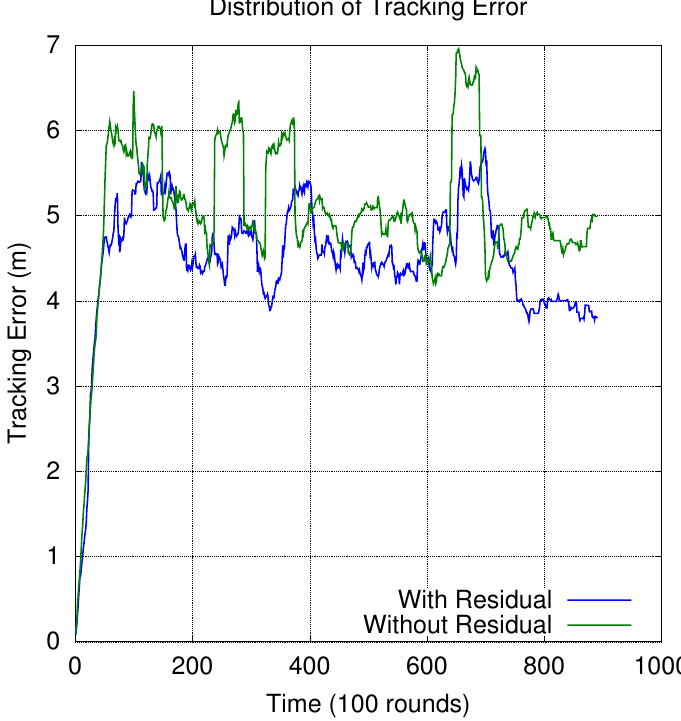
Table 1. Use of Residual in Density